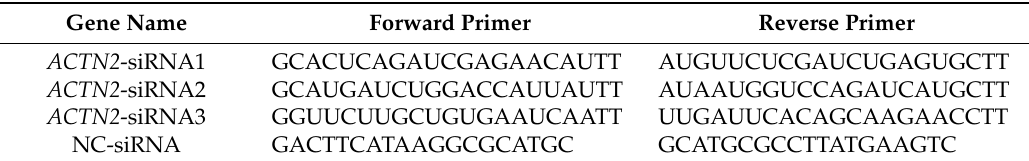
Table 4. Target siRNA sequences of ACTN2